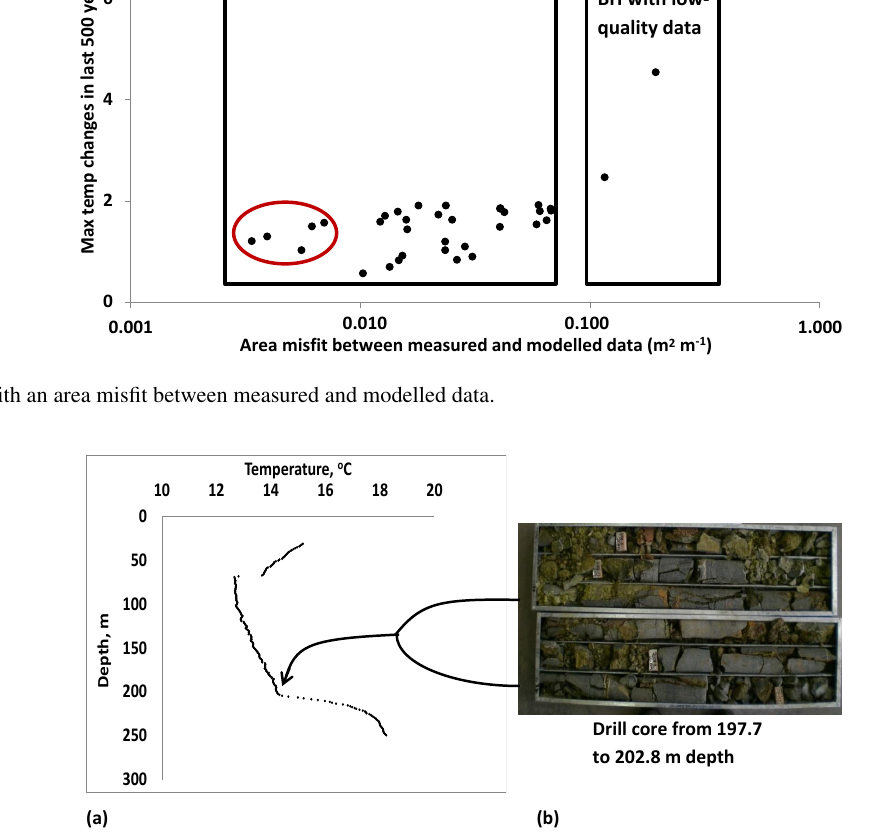
Figure 6. (a) Borehole temperature profile (Oatlands borehole) suspected to have been affected by groundwater movement at ∼ 200m. The upper discontinuity may be due to horizontal groundwater flow. (b) Broken drill core from 197.7 to 202.8m. The high frequency of fractures suggests highly permeable rock and groundwater movement (Photo courtesy of Oatlands borehole, KUTh energy,